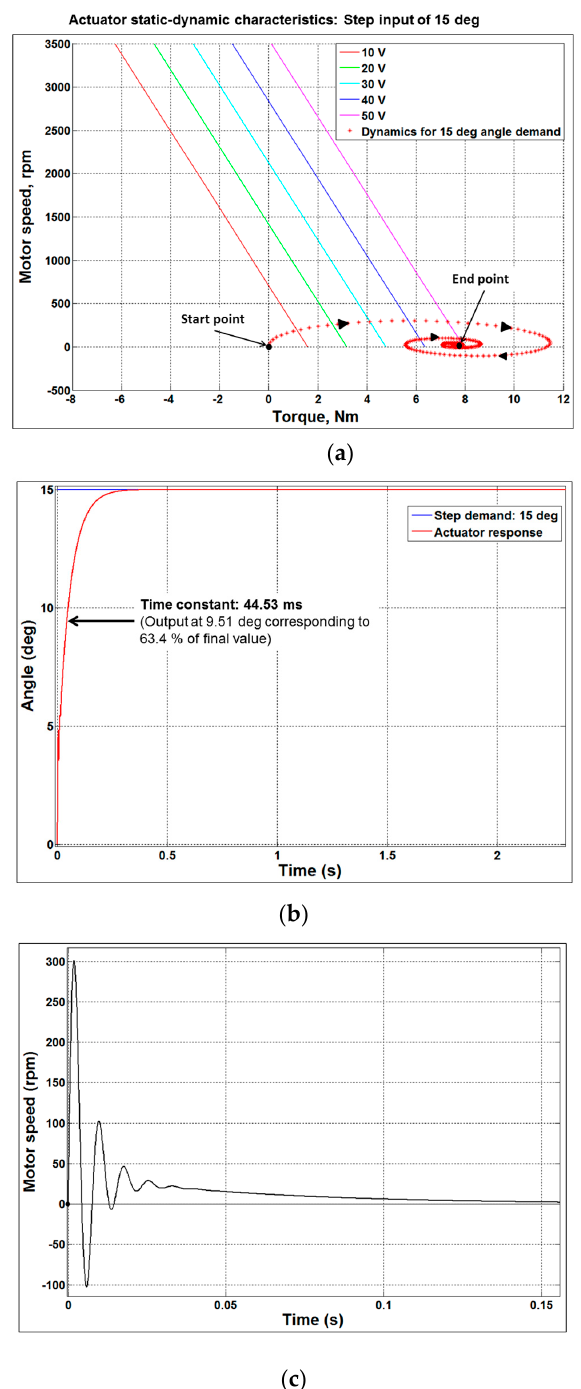
Figure 8. Cont. Figure 8.